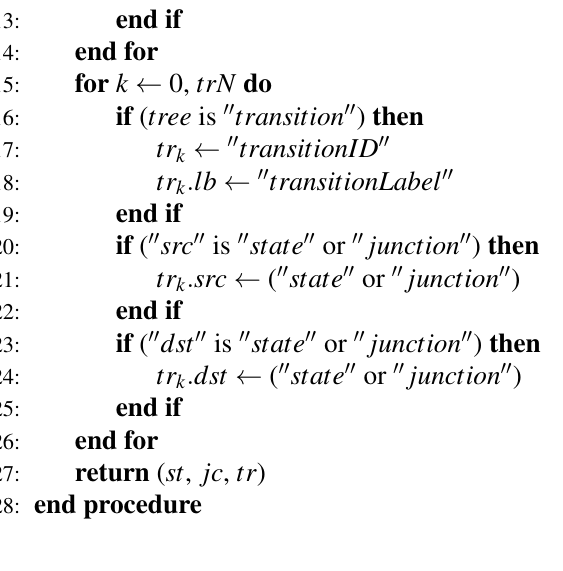
Fig.3 performs the translation from XML to a finite state machine intermediate specification for a deterministic or nondeterministic model. Line 3